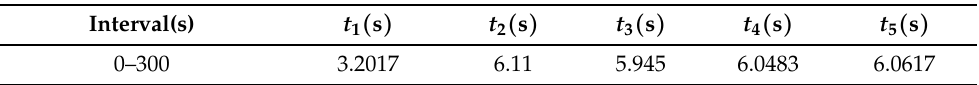
for the different dynamic gains models. opt